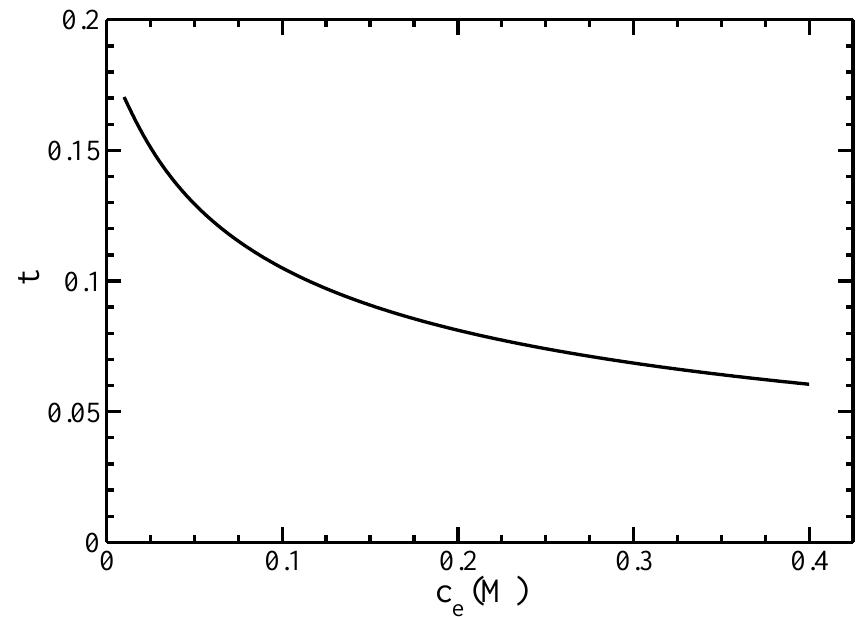
Figure 13. The twisting parameter t as a function of the monovalent ions’ concentration c e